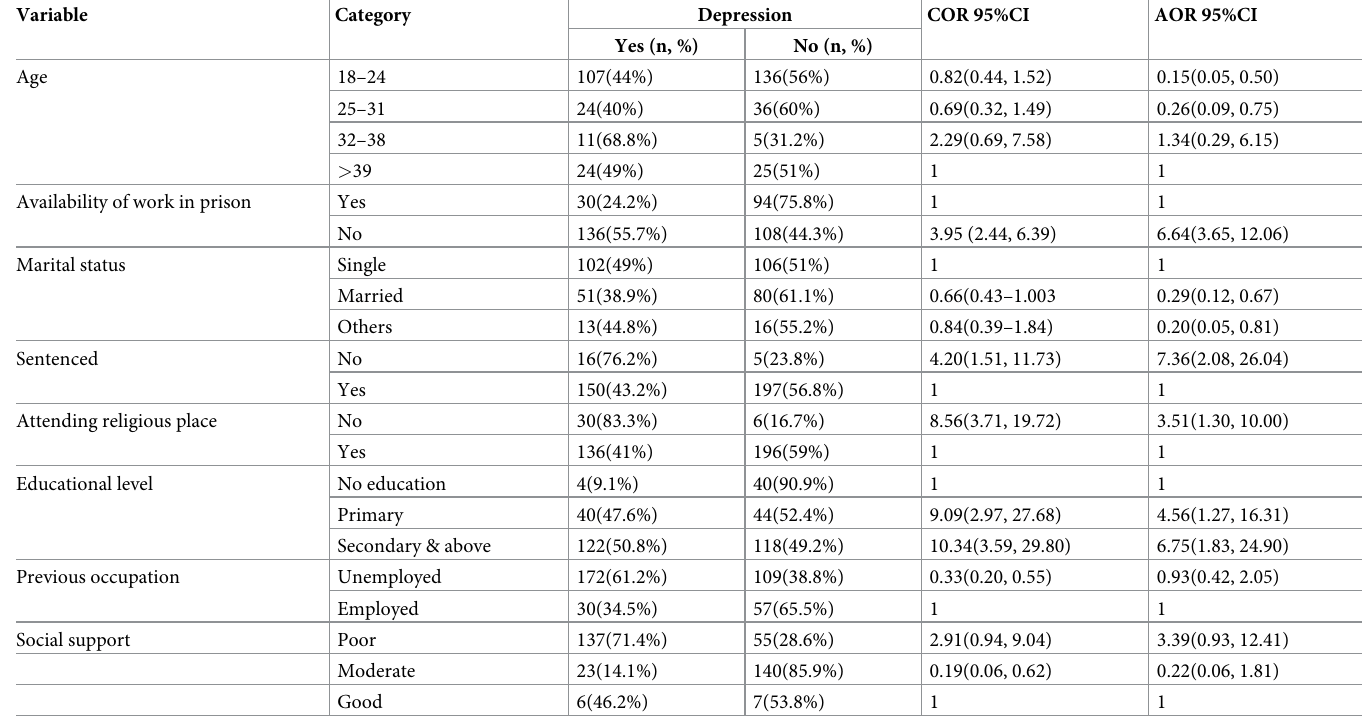
Table 3. Factors associated with depression by multivariable logistic regression among prisoners in Wollega zones prisons, West Ethiopia, (n =